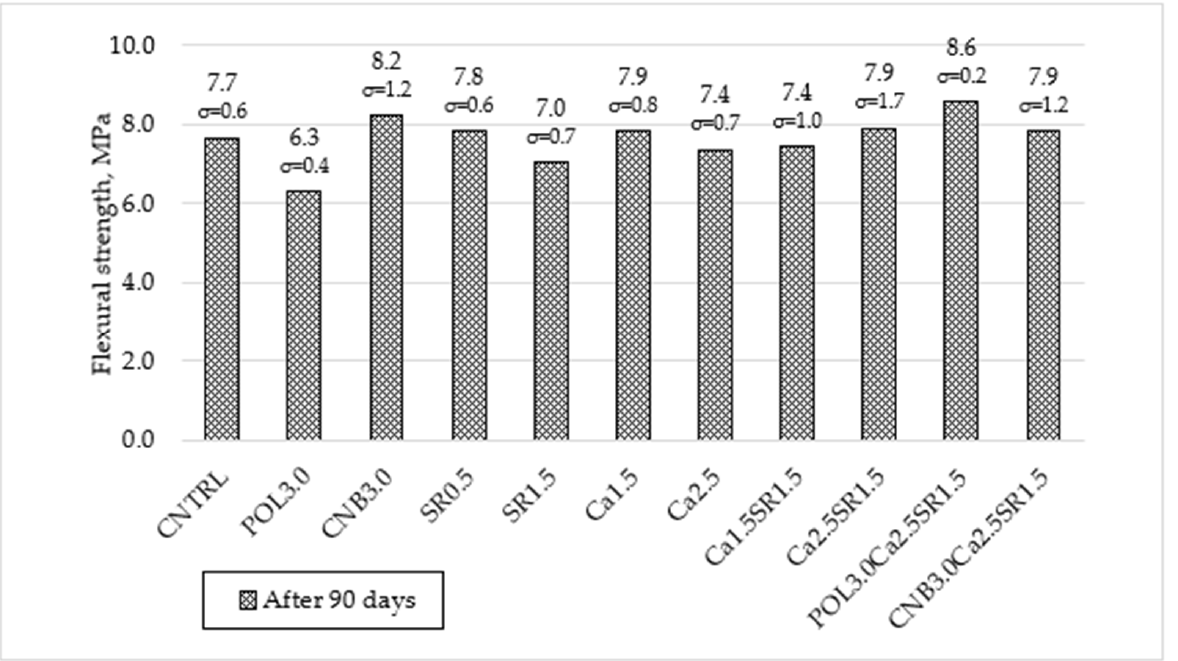
Figure 5. Relationship between specimen density after 28 days and air content.